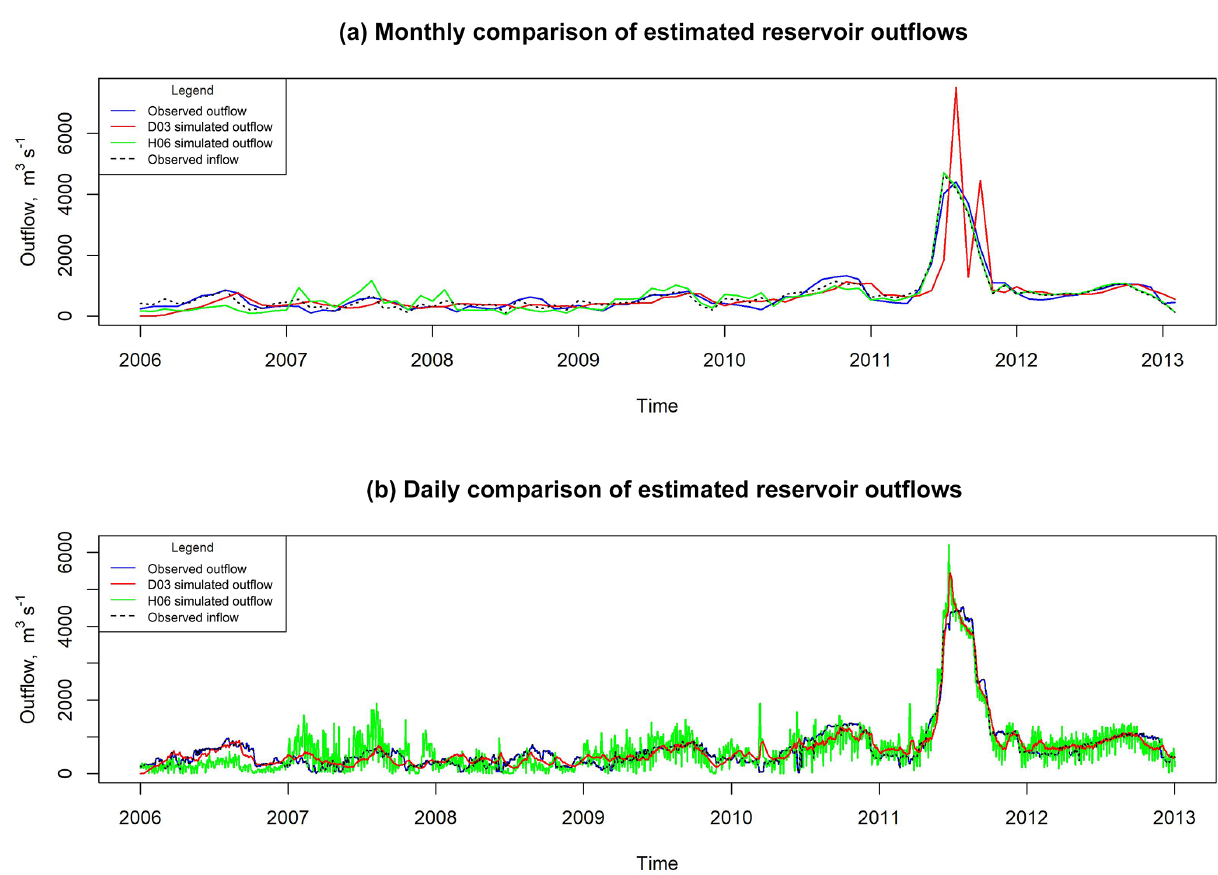
Figure 10. Comparison of simulated outflow for the Fort Randall Dam with Hanasaki and Döll methods for (a) monthly and (b) daily time